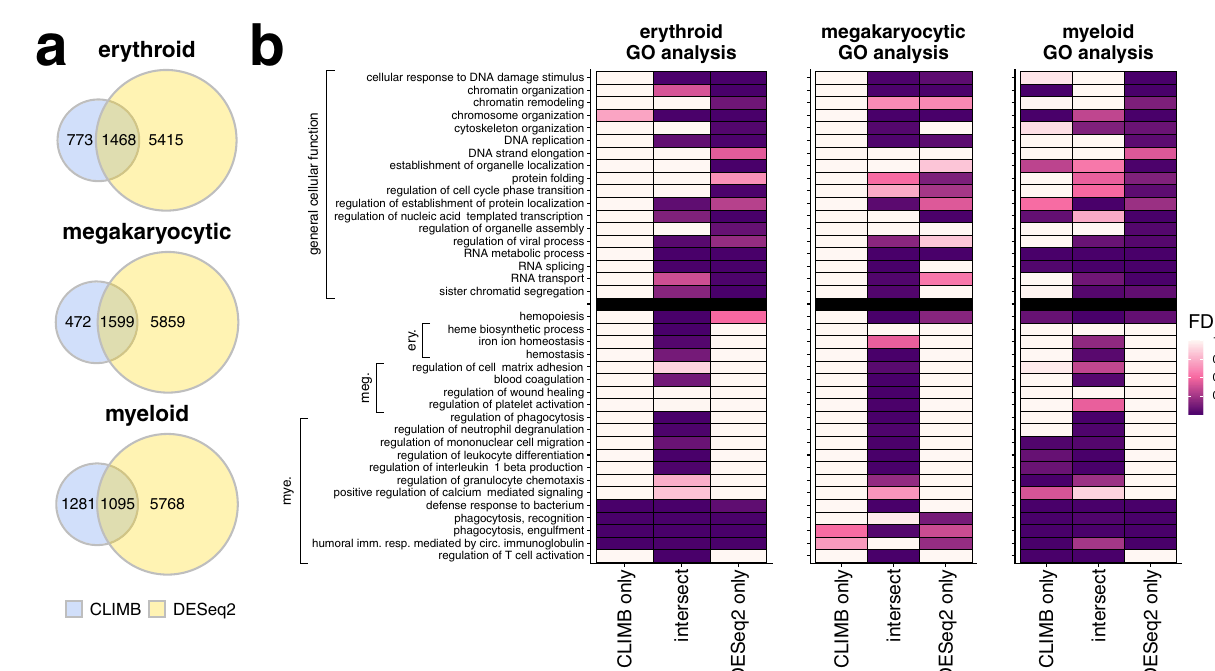
Fig. 4 | Comparison of differentially expressed genes identi fi ed by CLIMB and DESeq2. a Venn diagrams displaying overlap of differentially expressed genes identi fi ed by both methods across all analyses. b Signi fi canceofenrichment of GO terms in gene sets speci fi c to CLIMB, speci fi c to DESeq2, and in the intersection of both methods, for each studied lineage. Presented GO terms are organized